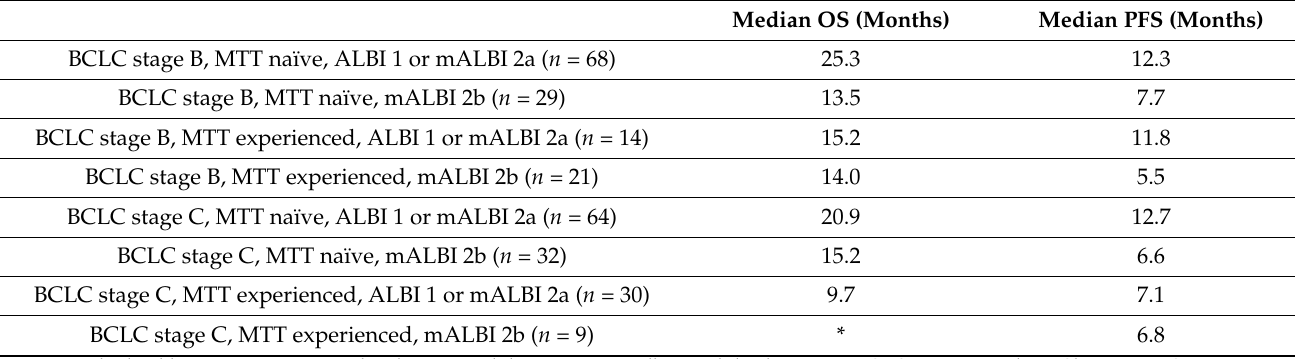
Table 3. The median OS and PFS according to BCLC stage, MTT experience, and ALBI or modified ALBI grade in Child-Pugh A